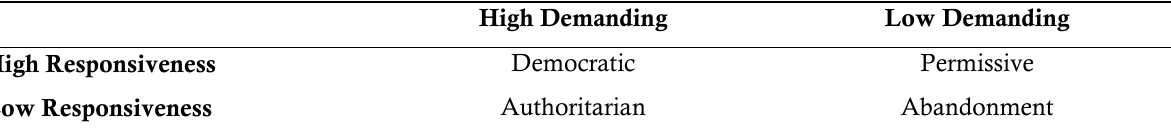
demanding* Table 2. The quadrant of parenting eating patterns classification based on responsiveness and demanding Table 2. The quadrant of parenting eating patterns classification based on responsiveness and demanding Table 2. The quadrant of parenting eating patterns classification based on responsiveness and Table 2. The quadrant of parenting eating patterns classification based on responsiveness and demanding